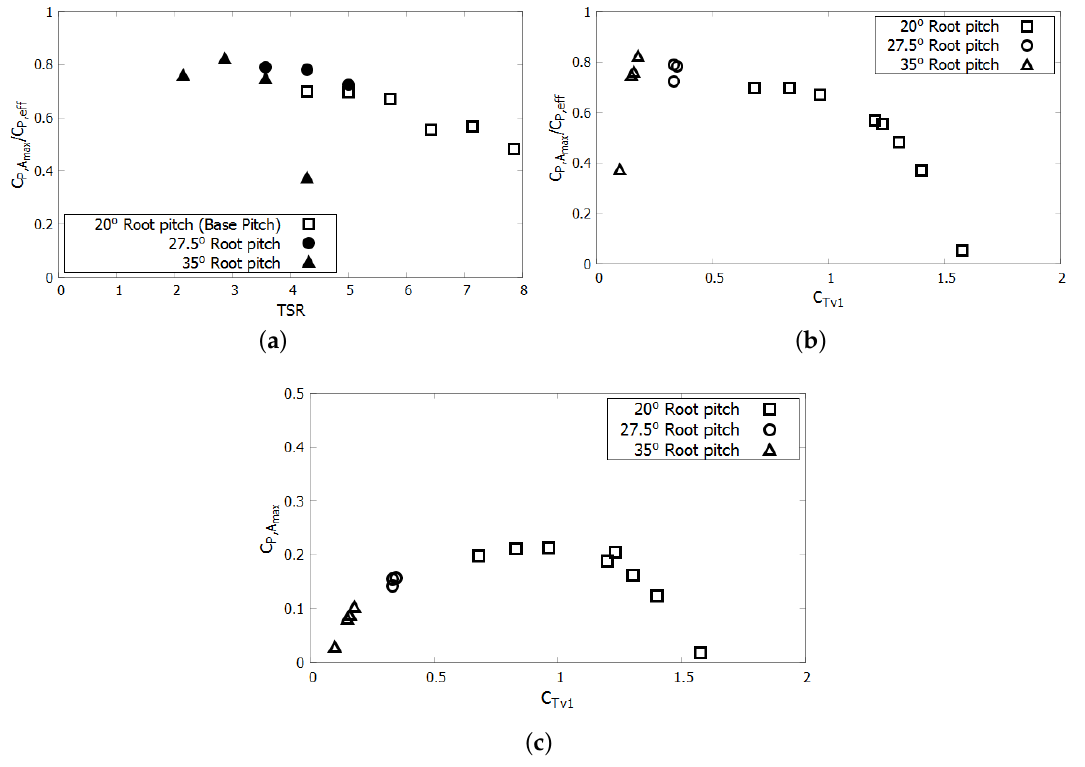
Figure A1. Effect of pitch on the power ratio and C P , A ( c ) C P , A vs. C Tv 1 max